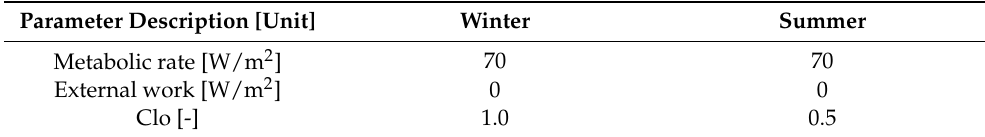
Table 3. Input parameters for occupant’s